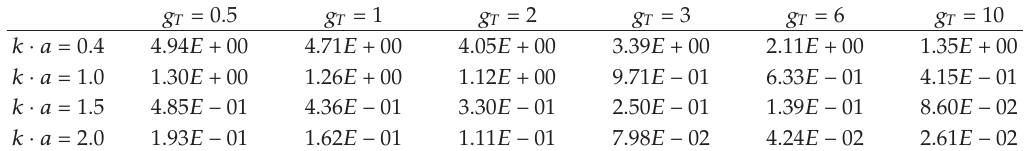
Table 1: Modulus of the inner pressure p in0 / (cid:4) H/ 2 (cid:5) for various values of g T and ka , for a restrained OWC device.